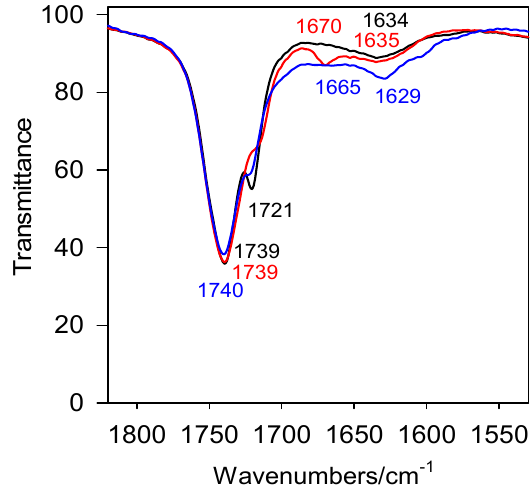
Figure 3. FT-IR spectra of sterol gemini conjugates in the 1,800–1,550 cm − 1 region for 6 (blue), 9 (red), 12